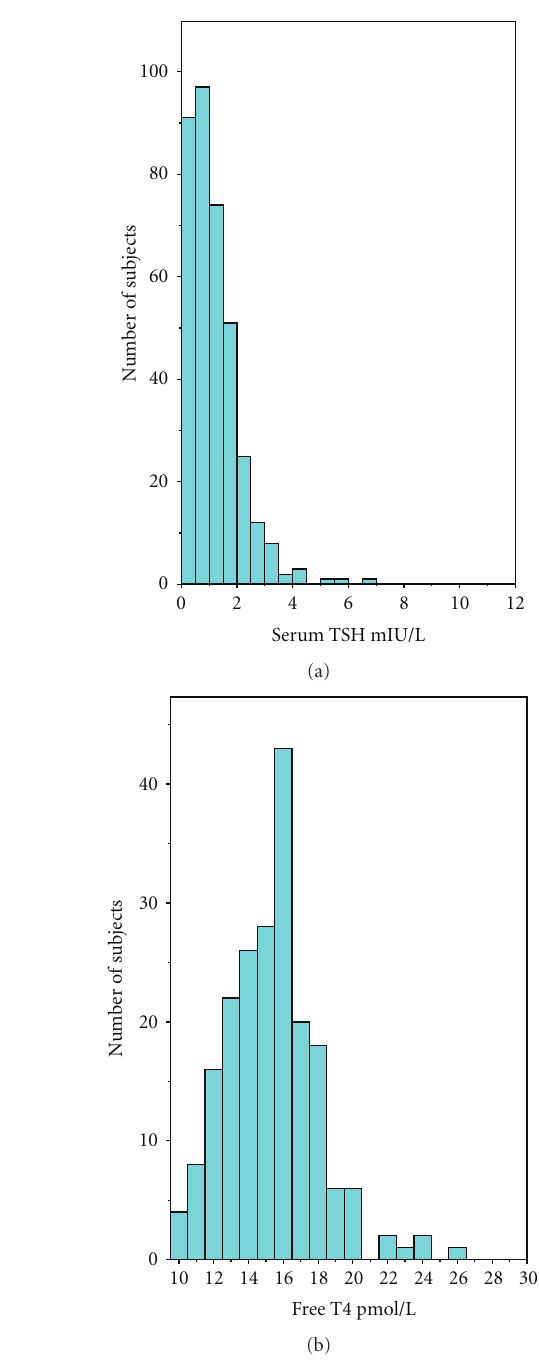
Figure 1: Frequency distribution of UIC in all women. Figure 2: Frequency distributions of serum TSH and Free T4 con-